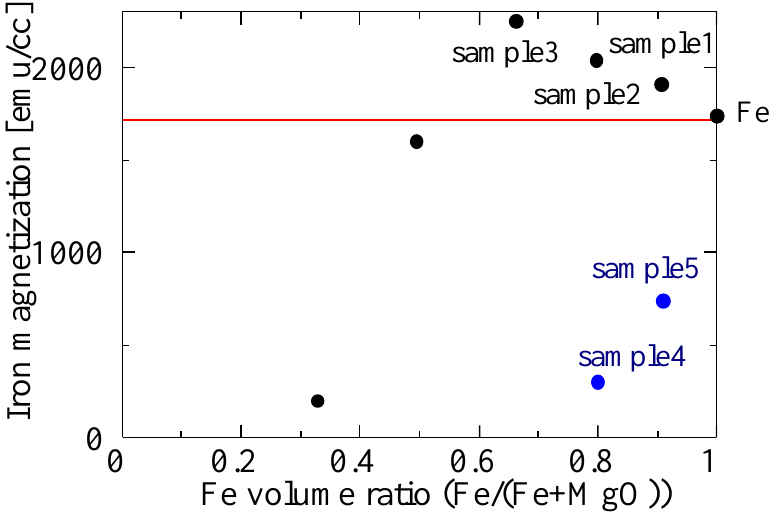
Figure 3. The magnetizations of Fe layers for Fe/MgO multilayered films. Samples 1, 2 and 3 denotes Fe(10 nm)/MgO(1 nm), Fe(4 nm)/MgO(1 nm) and Fe(2.5 nm)/MgO(1 nm), respectively. Sample 4 and 5